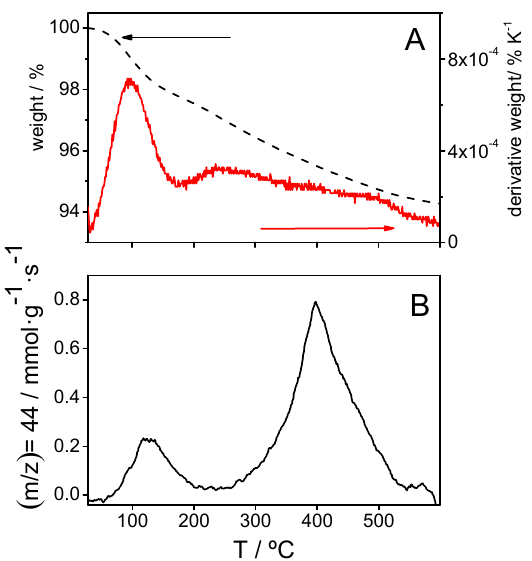
Figure 3. ( A ) Thermogravimetric curve (black dashed line) and first derivative TG curve (red solid line) and ( B ) mass spectrometry signal for m/z = 44 obtained from silica synthetized by the electrochemical method.